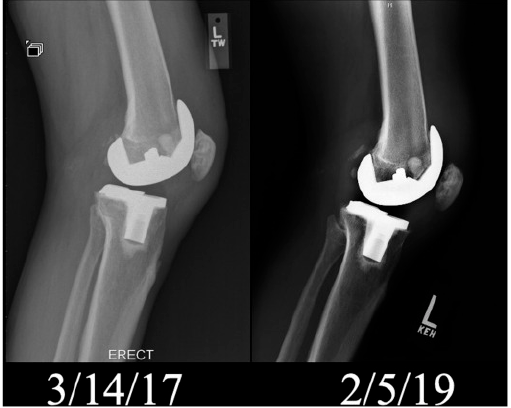
Figure 9. Radiograph (lateral view) of left knee post ‐ op and after 2 ‐ years follow ‐ up. Reproduced from [127] with the permission from Elsevier™.